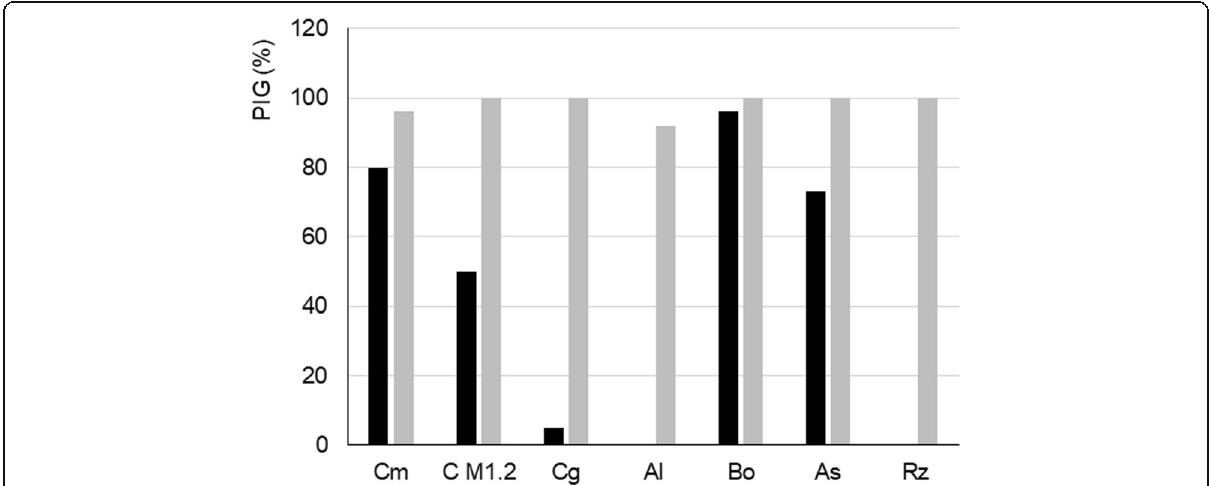
Fig. 4 Effects of BE on percentage of inhibition germination (PIG) of conidia. The germination was registered after 22 h of extract application. Cm,